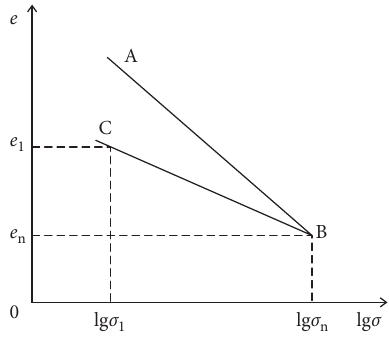
Figure 14: Rebound curve of soil (BC